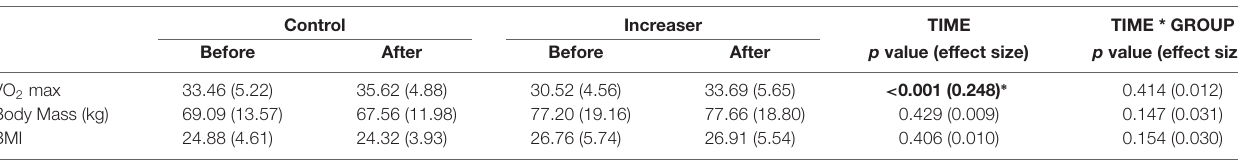
TABLE 2 | Body mass and fitness.